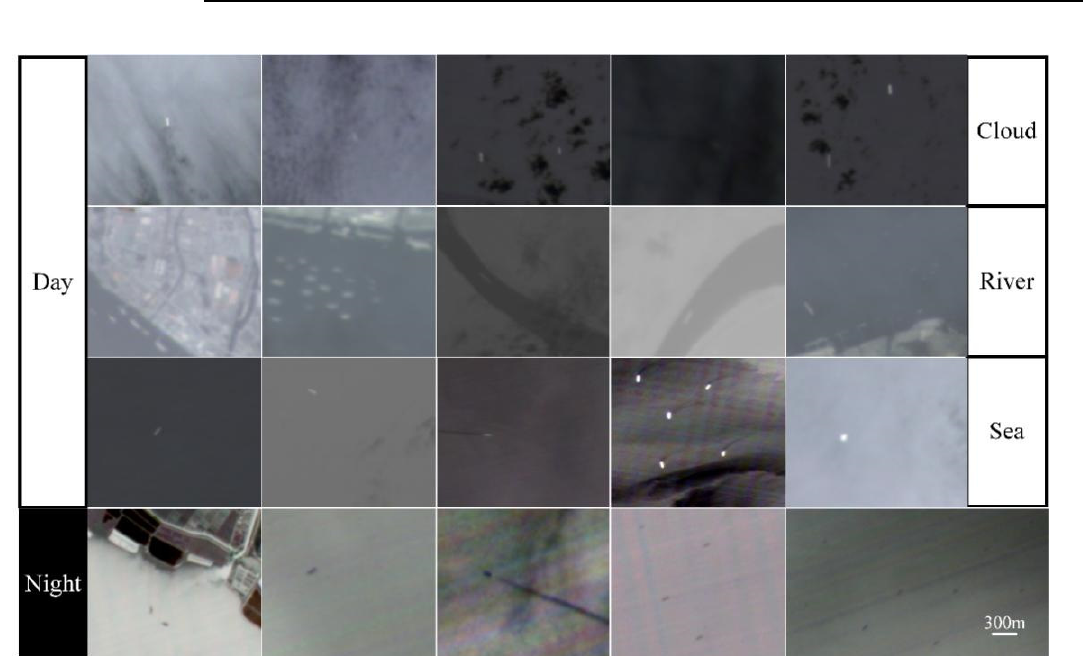
Figure 6. Parts of day and night images in the cloud, river, and sea scenes of the TISD.